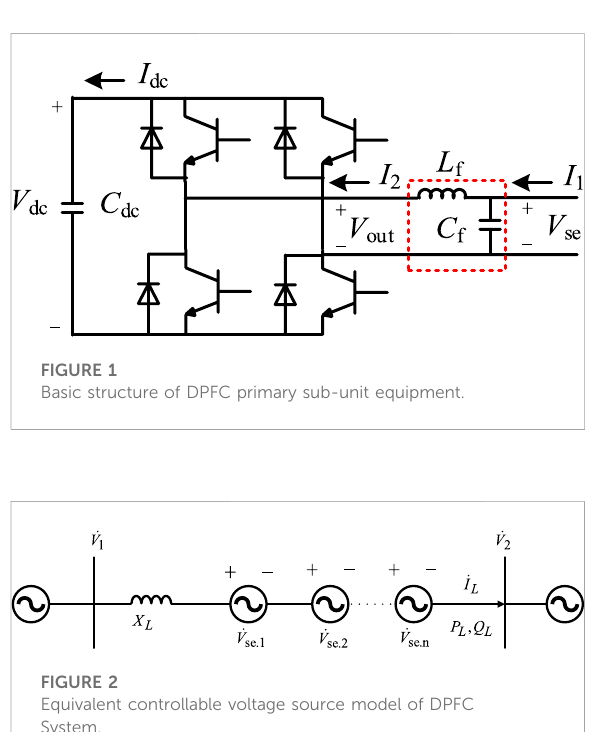
FIGURE 2 Equivalent controllable voltage source model of DPFC